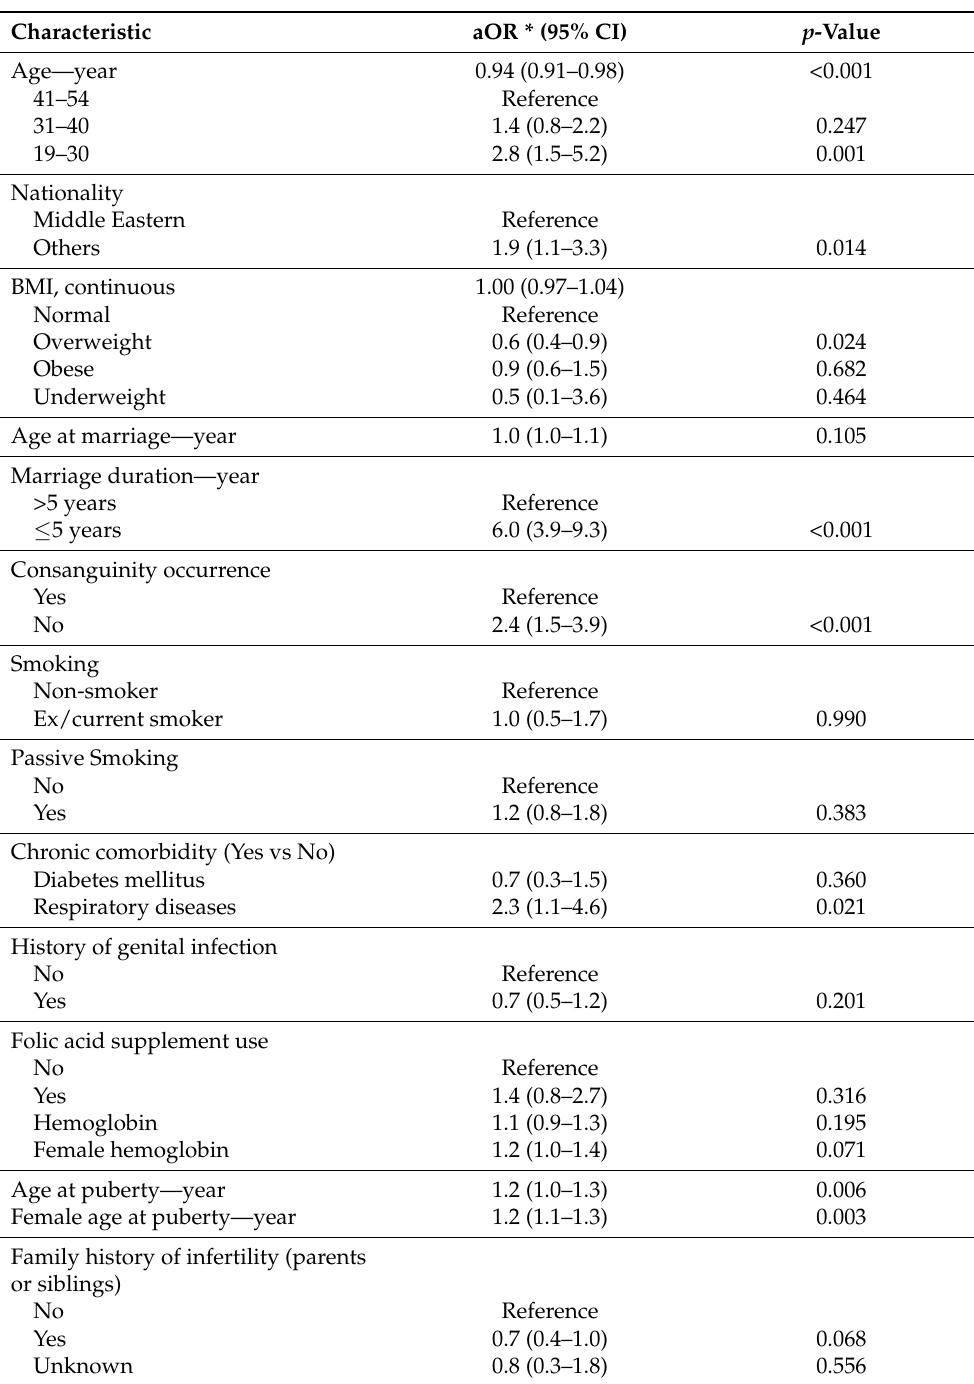
Table 5. Adjusted characteristics associated with primary infertility in fertility clinics